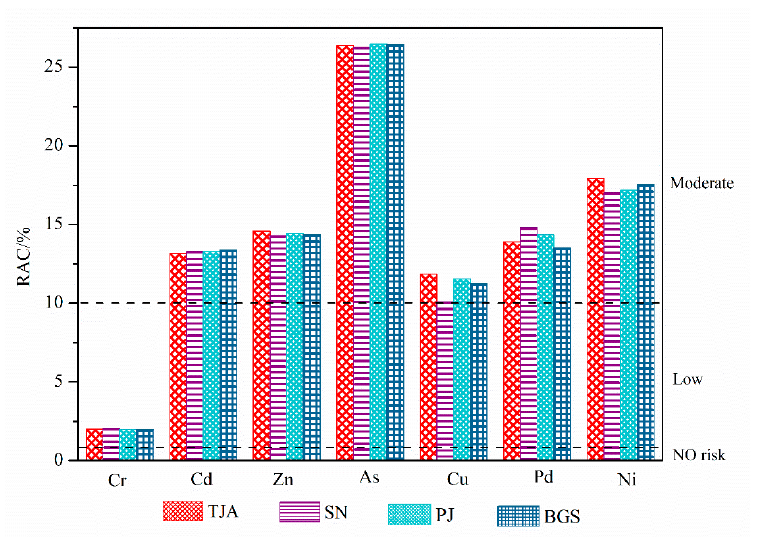
Figure 4. The RAC results for the heavy metals in the sludge. TJA (Tianjiaan), SN (Shannan), PJ (Panji), and BGS (Bagongshan).